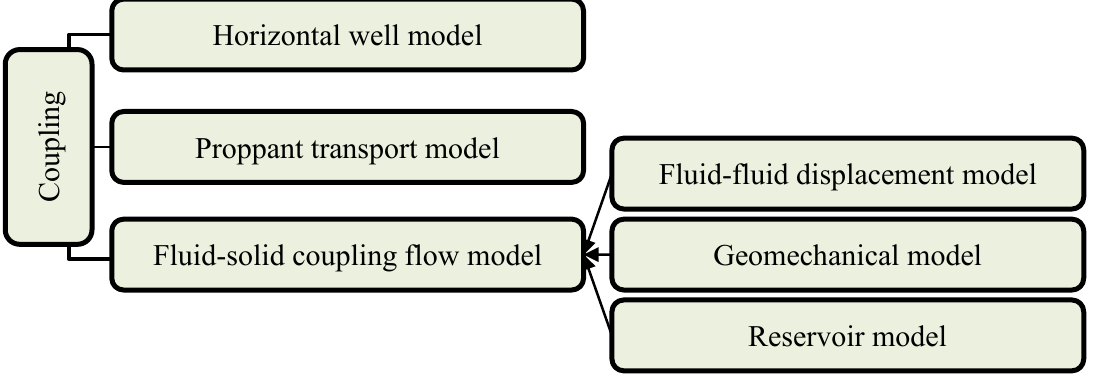
Figure 1—Schematic representation of the component parts of a flowback